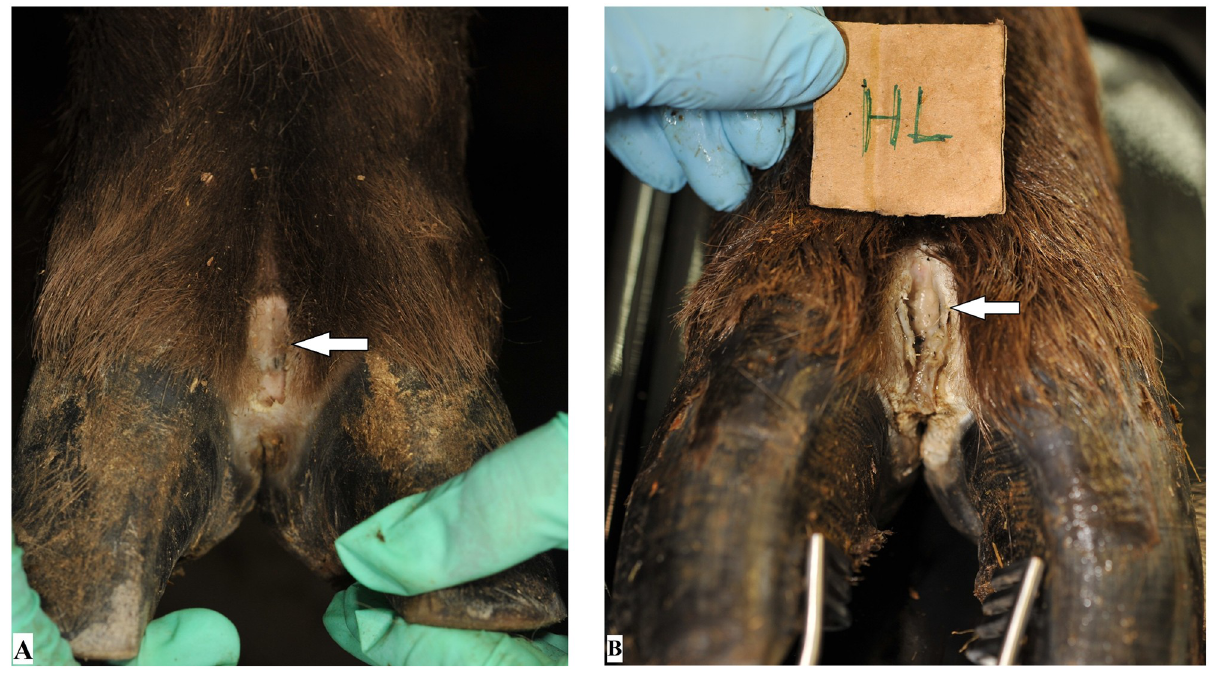
Fig 1. Feet of captive European bison ( Bison bonasus ) with digital dermatitis lesions (indicated with arrows). (A) Left front foot of animal no. 7 with a focal lesion (score 1) on the dorsal aspect of the digital skin. (B) Left hind foot of animal no. 10 with an extended lesion involving the dorsal digital skin and the interdigital cleft (score 2) of the digital skin. Hair growth around the lesions in A and B was rated normal (score 0).